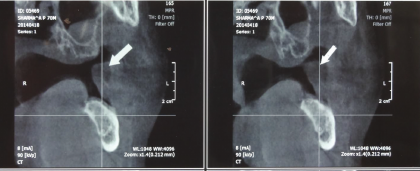
Figure 3: CBCT reveals heterogeneous lesion in left buccomasse- teric region extending into left sided retromolar region.